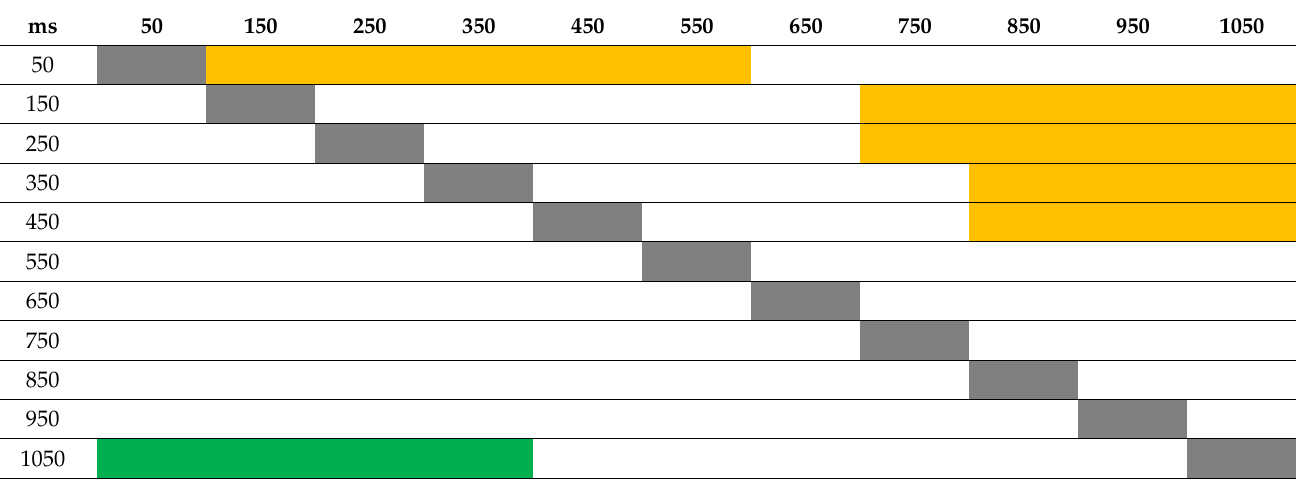
Figure A10. RMSE ( left ) and cross-correlation ( right ) for ZC with different thresholds (Q multipliers of MAV at rest) and window widths (actual value of Q is shown/10).